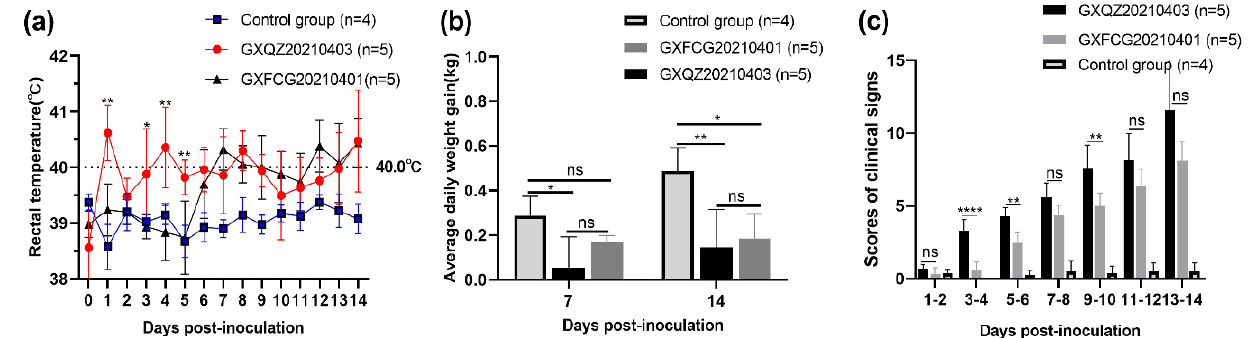
Figure 5. ( a ) The rectal temperatures of piglets inoculated with GXFCG20210401, GXQZ20210403 and DMEM media. The clinical fever cut-off value was set at 40.0 °C. ( b ) The average daily weight gain of the inoculated piglets during each week in the challenge trial. ( c ) The clinical sign scores for inoculated piglets. The values are expressed as means ± standard deviations, the bars represent the average values and error bars indicate standard deviations. Asterisks indicate the significant differences between the GXFCG20210401 and GXQZ20210403 infection groups when compared to the controls (* p < 0.05; ** p < 0.01; **** p < 0.0001; ns, no significant difference).